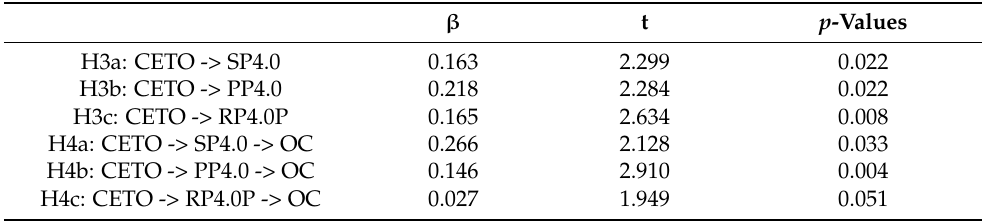
Table 4. Direct and mediated relationships (H3 and